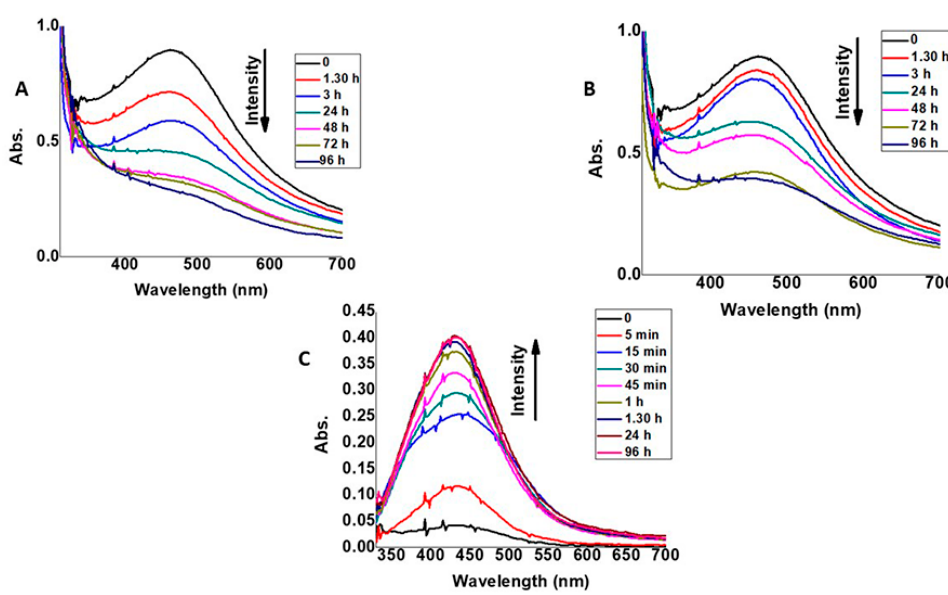
Figure 2. UV-Vis analysis in water. ( A , B ) The absorbance of hgel@AgNPs-3MPS at RT and 4 °C, respectively. ( C ) The absorbance of hgel@AgNPs-SDS at RT.